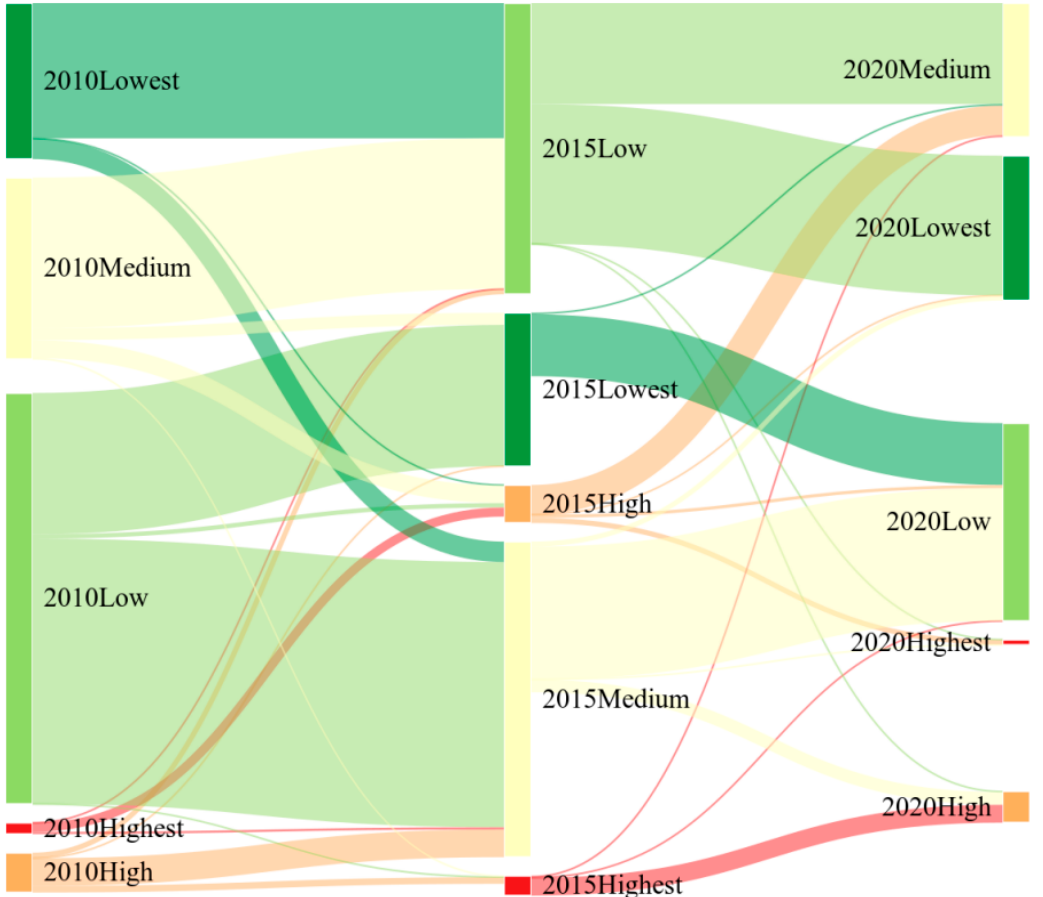
Figure 6. Transfer of ecological-economic space conflict change zone in Nanjing metropolitan area from 2010 to 2020 (the color of the highest, high, medium, low, and lowest five different spatial conflict levels is consistent with those in Figure 5) .